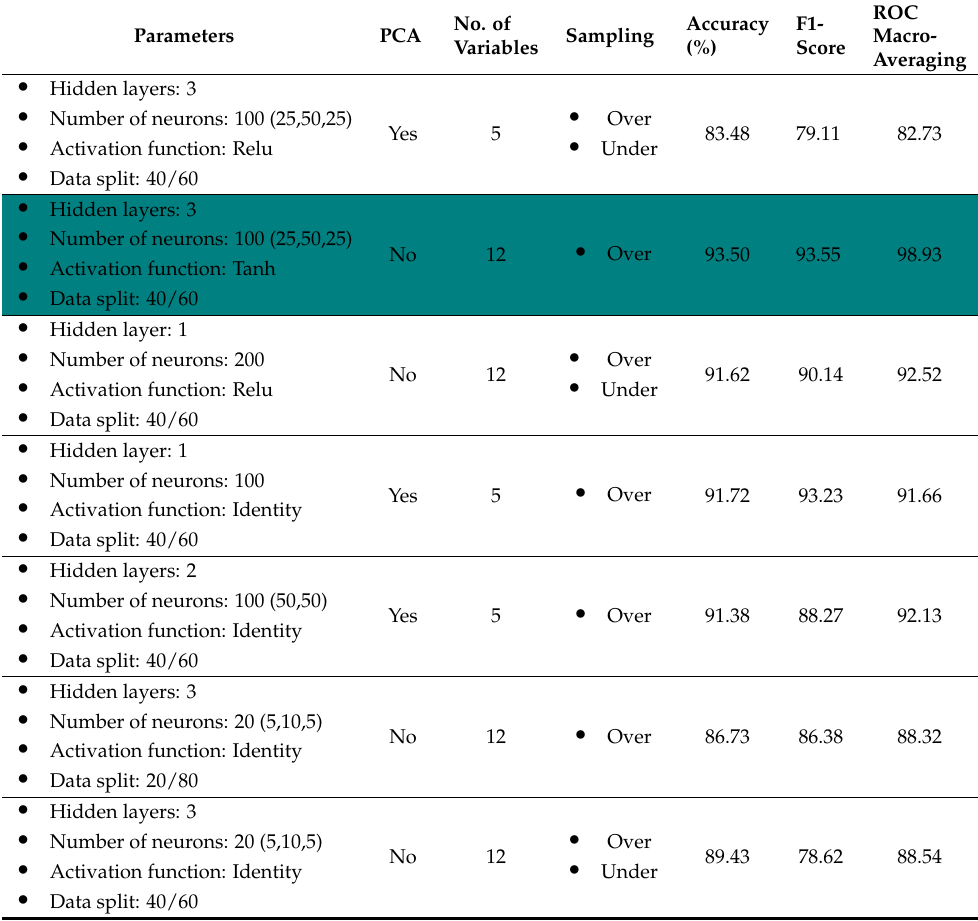
Table 5. The performance of Multi-layer Perceptron classifiers.